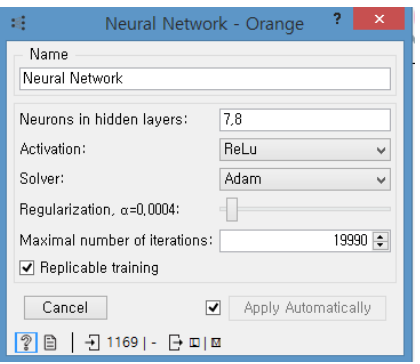
Figure 8. Parameters of the proposed ANN model [79].